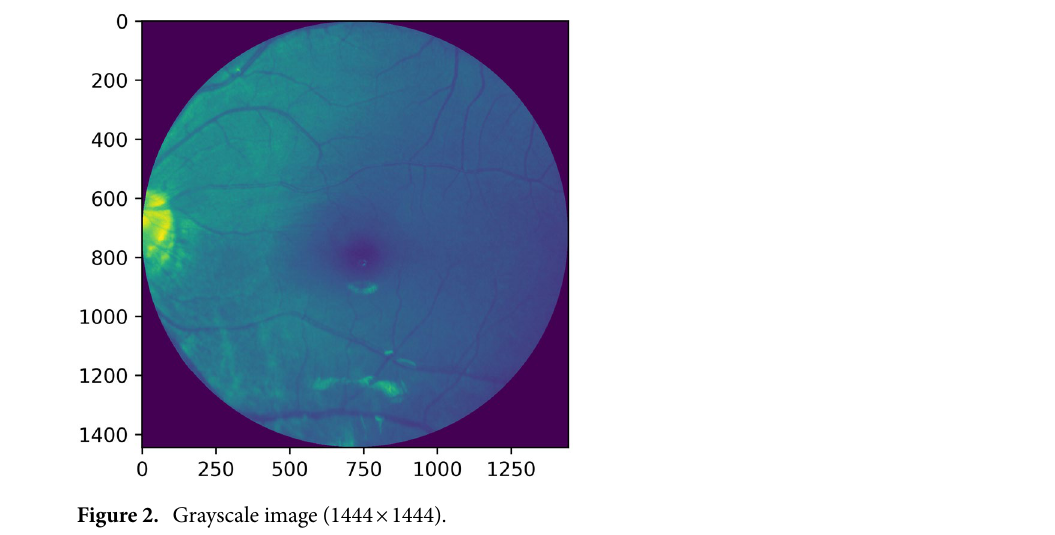
Figure 2. Grayscale image (1444 ×